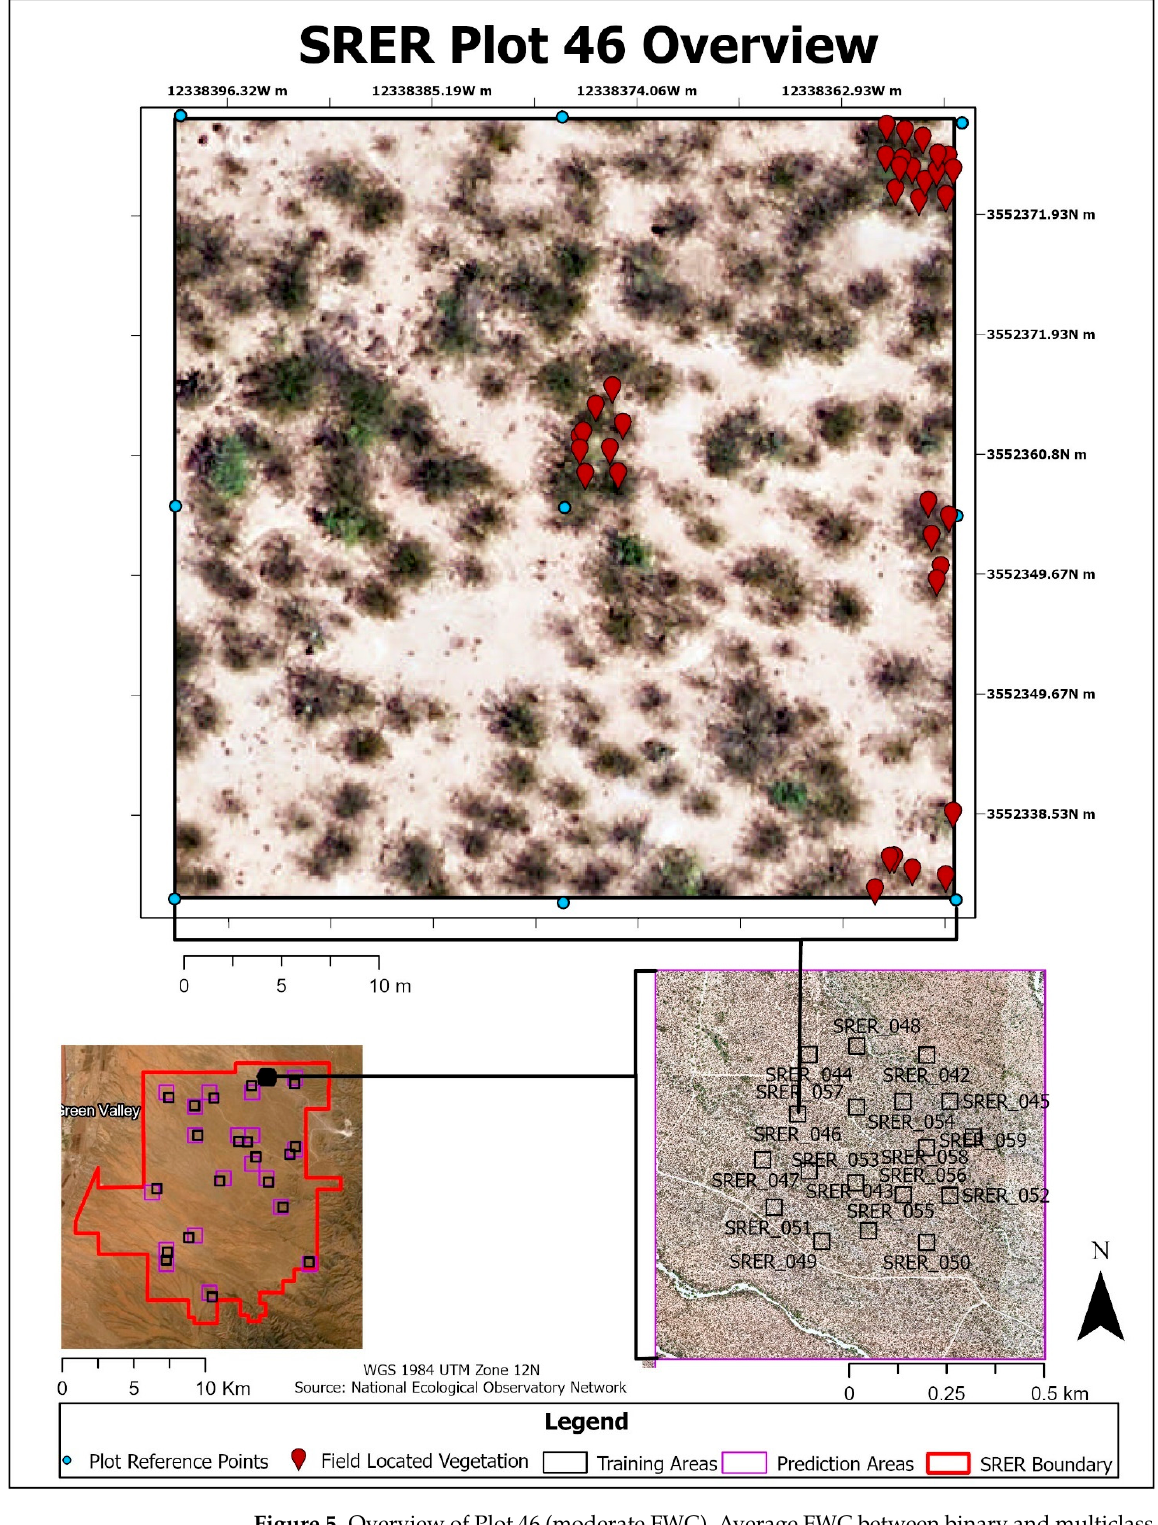
Figure 5. Overview of Plot 46 (moderate FWC). Average FWC between binary and multiclass training data was 33.73%. Plot 46 is a tower plot and is representative of the most dominant vegetation properties at SRER, which is why there are many plots within its image tile. This plot is also double the dimensions of the distributed plots (1600 m 2 instead of 400 m 2 ). Due to its size, field located vegetation is concentrated in four regions. Vegetation for this plot is denser than Plot 14.